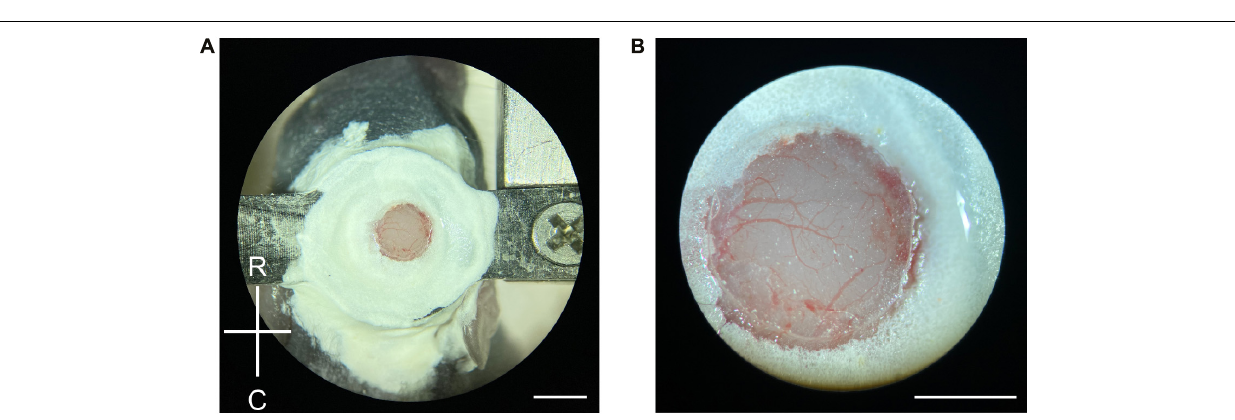
FIGURE 2 | Craniotomy in neonatal mice. (A) Demonstration of a newly made craniotomy on a P6 mouse. The cranial window is about the same size as the 2-mm diameter coverslip. R, rostral; C, caudal. Scale = 2 mm. (B) A close-up view of the craniotomy after the completion of the surgery. Blood vessels are clearly visible with minimal bruising. Scale = 1